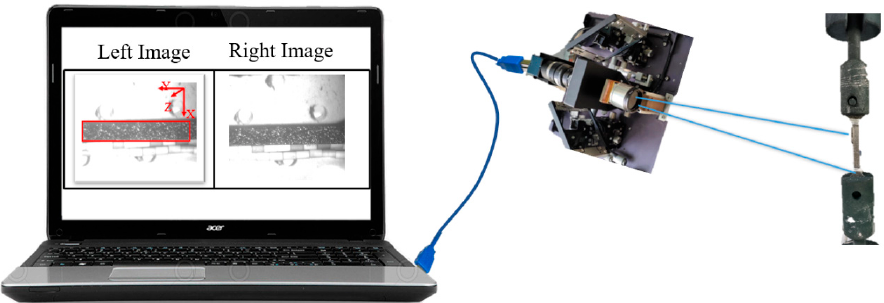
Figure 8. Schematic diagram of the specimen surface for observation and calculation.